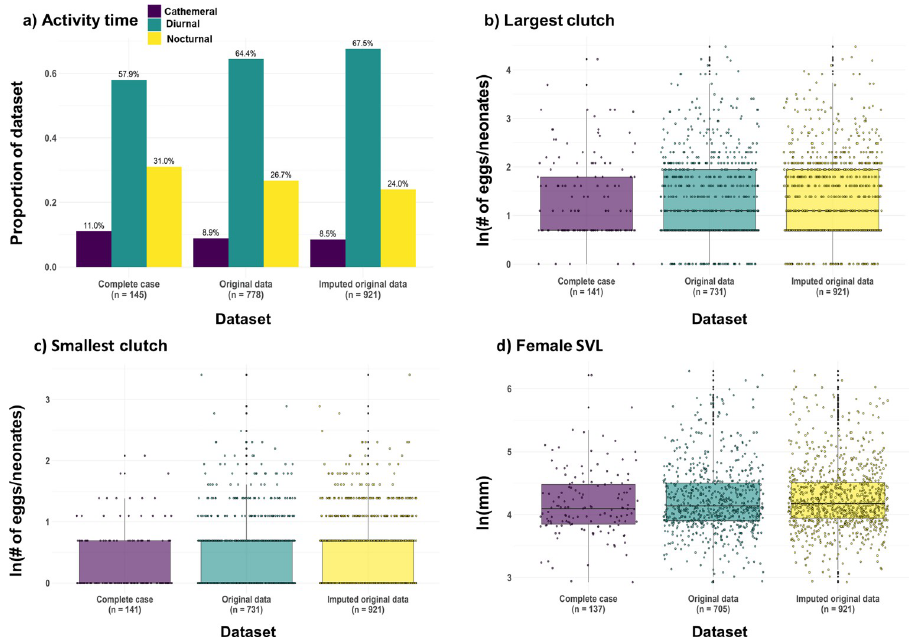
Fig 6. Comparison of quantitative characteristics across datasets. Comparison of a) categorical frequencies for the trait activity time and distributions for the traits b) largest clutch, c) smallest clutch, and d) female SVL of the complete-case data, original data, and imputed data. The natural logarithm (ln) of the numerical data were taken to improve visualization.